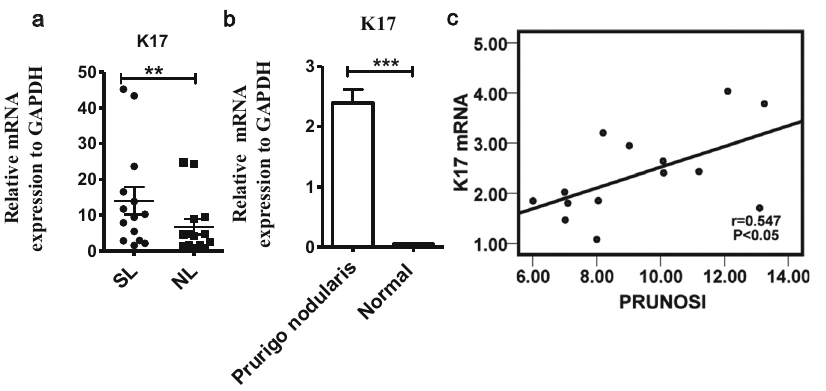
Figure 3: Keratin 17 ( K17 ) mRNA expression levels in lesional and perilesional skin of patients with PN compared with those of healthy volunteers. ( a ) Real - time PCR analysis of K17 mRNA expression levels ( n = 14 ) . The levels are compared between the lesional skin and perilesional skin. ( b ) K17 mRNA expression levels are compared between the PN lesional skin and normal healthy skin. ( c ) Spearman analysis of PRUNOSI ( x - axis ) and K17 gene expression ( y - axis ) ; in the scatter plot, r = 0.547, * P < 0.05, regression line Y = 1.551 x + 5.616, and regression coe ffi cients R 2 = 0.32. SL, lesional skin; NL, perilesional skin. Values show the expression/GAPDH level and are presented as mean ± SEM. Asterisks above the error bars denote comparisons between the matched lesional and perilesional skin. * P < 0.05, ** P < 0.01, and *** P < 0.001, by paired Student ’ s t